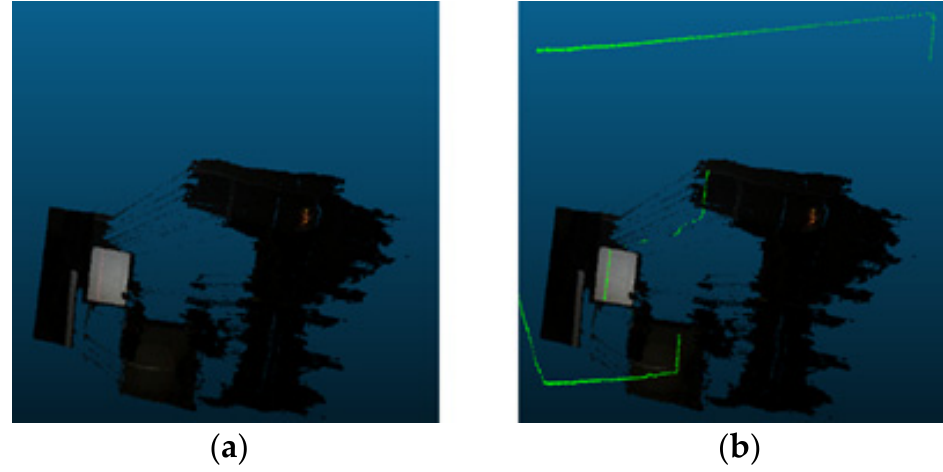
Figure 4. Example of detecting the center point from the depth information acquired by LIDAR and stereo. ( a ) A center point of the line in LIDAR data; ( b ) A center point of the line in the camera data. After placing the calibration board at various positions and obtaining the transforma- tion matrices using Equation (2), an accurate projection of the data obtained from the LiDAR sensor onto the position of the line laser was available, as shown in Figure 5. The accuracy of calibration becomes greater with the increasing number of match points, but this study confirmed that six were sufficient. Figure 6 shows the results when inter-device calibration was performed and when it was not.